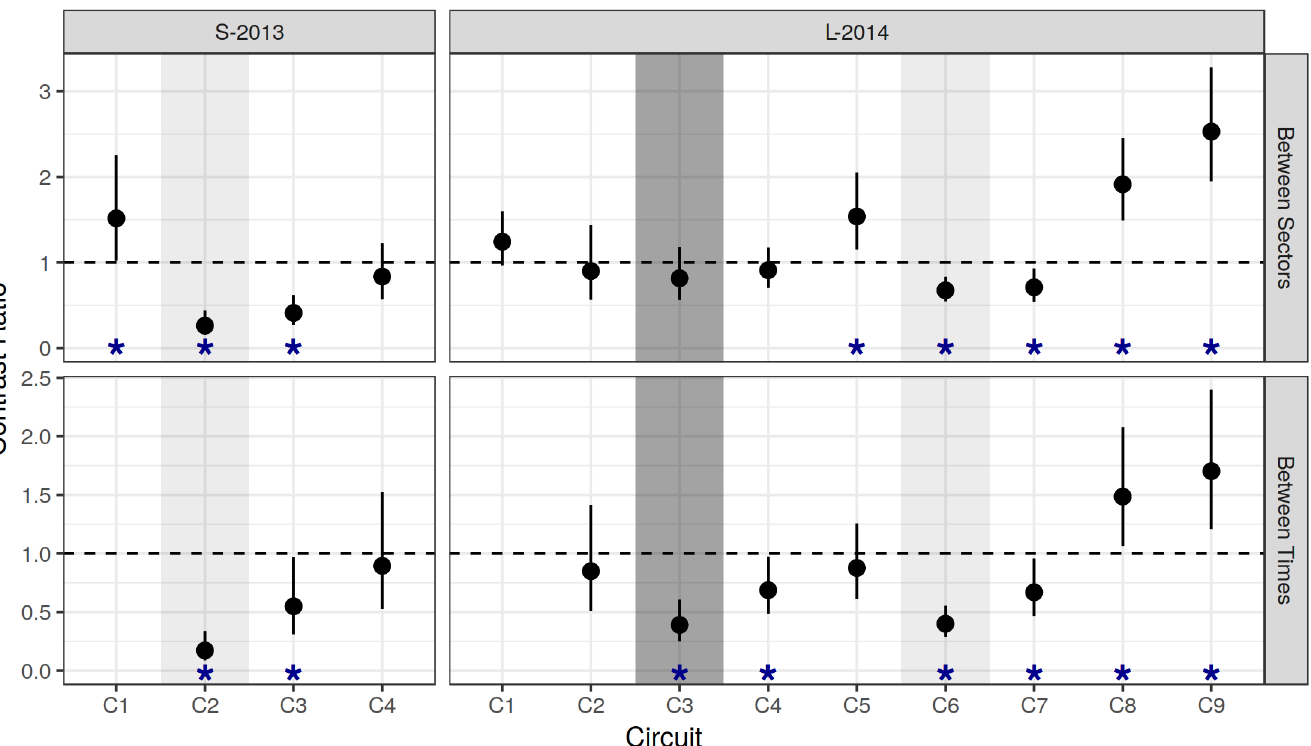
Fig 5. Contrast ratios of AA/HSE, based on NB-GLM. Results from NB-GLM models (Fig 4A). Top row (between-sector): Spray/Buffer. Bottom row (between-time, within spray sector): contrast relative to baseline (C1). Vertical bars show 95% CI. Horizontal dashed line indicates null hypothesis of equality (H 0 : ratio = 1). Asterisks ( (cid:3) ) indicate significant difference between pairwise contrasts (reject H 0